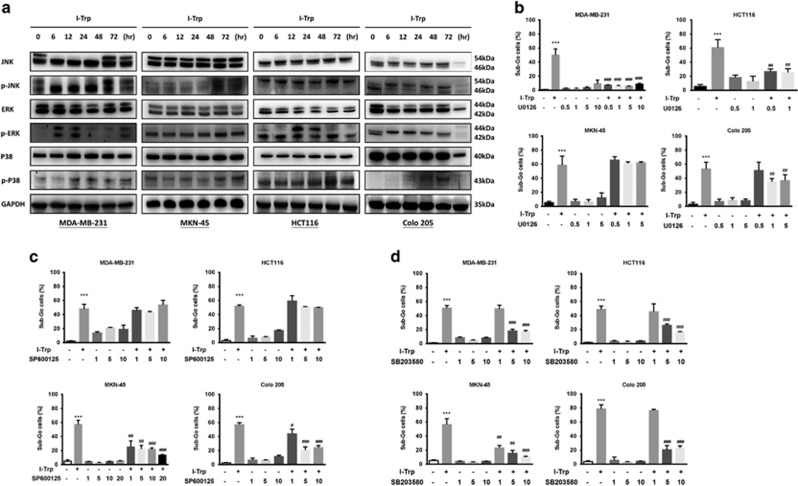
I-Trp promotes ER stress-induced cell apoptosis via the MAPK pathway upon CCT-β : β-tubulin complex destruction. (a) Quantification of cellular JNK, p-JNK, ERK, pERK, p38, and p-p38 upon I-Trp treatment by western blot. Using the kinase inhibitors to test the pathway of cell apoptosis induced by I-Trp. Commercially available ERK inhibitor U0126 (b), JNK inhibitor SP600125 (c), and P38 inhibitor SB203580 (d) were used to inhibit the kinases, respectively, and the sub-G0 cells were accessed using flow cytometer. Data are expressed as mean±S.D. ***P<0.001, significant difference as compared to control. #P<0.05, ##P<0.01, and ###P<0.001 significant difference as compared to I-Trp alone